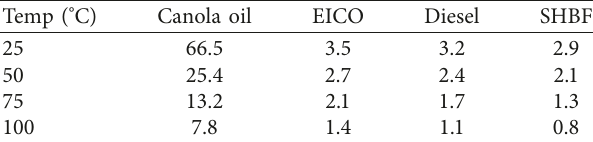
Table 4: Kinematic viscosity (cst) of base fluids at different temperatures.